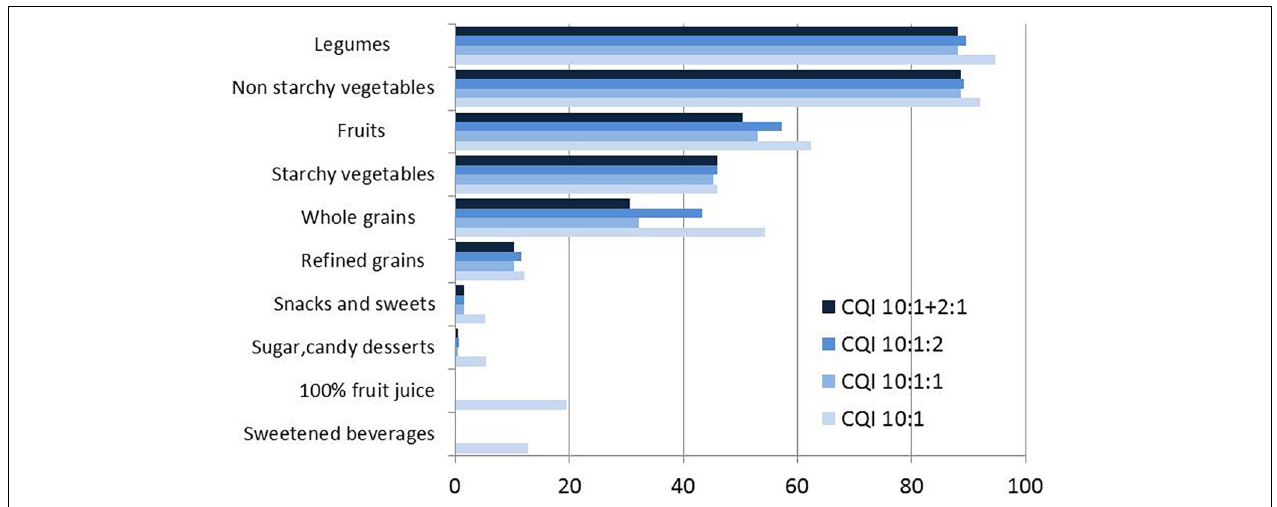
FIGURE 2 | Percent assignment to high quality CF based on four CQI models (3) by food group. The three models are: A) CQI 10:1, B) CQI 10 10:1:1, C) CQI 10:1:2, and D) CQI